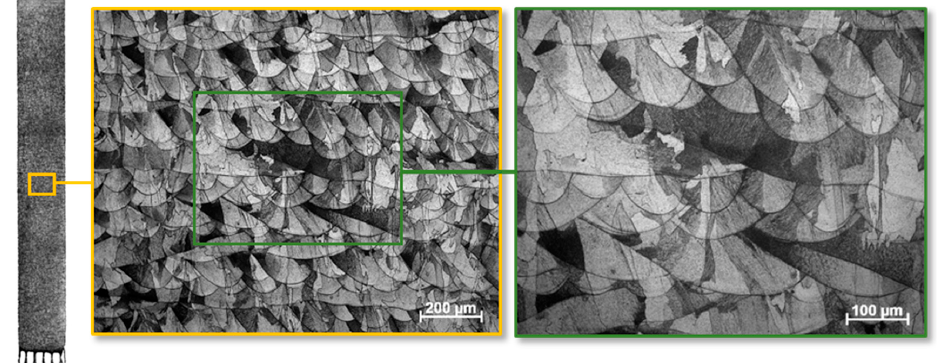
Figure 2. Microstructure of the SLM component.